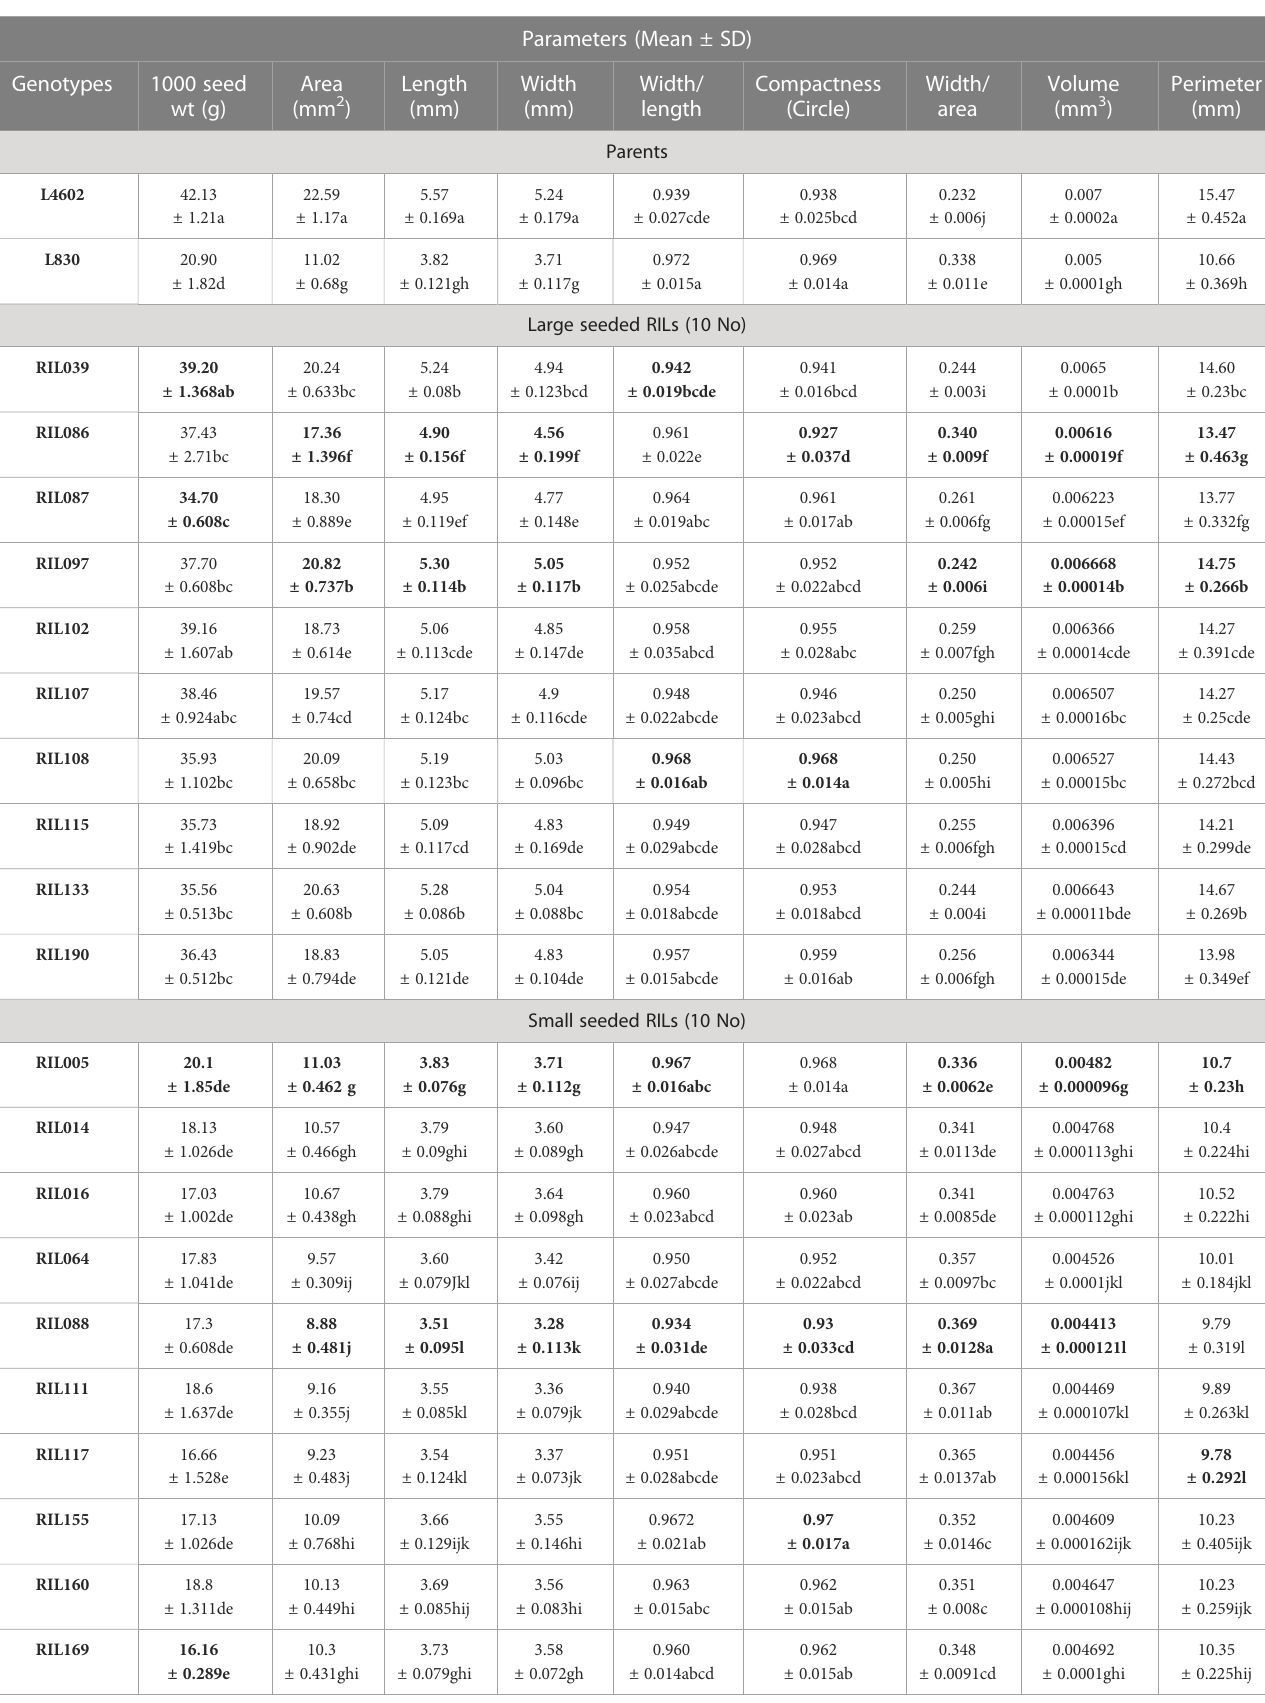
TABLE 4 List of seed parameters studied using VideometerLab 4.0 for parents (L4602 and L830) and the 10 extreme RILs.